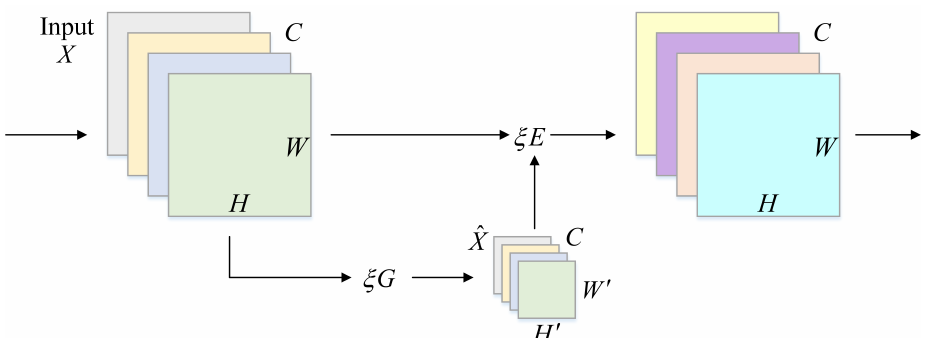
Figure 25. CBAM module architecture.